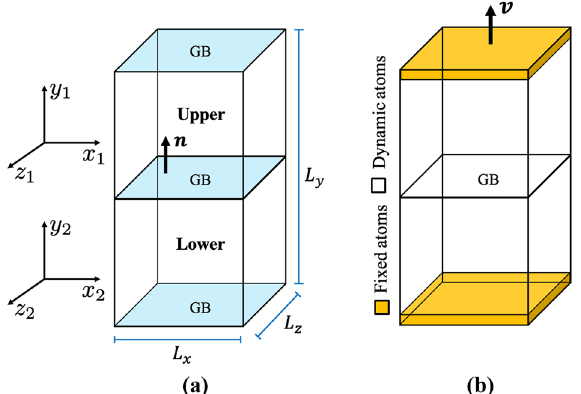
Figure 2. A schematic depicting (a) the geometry of the atomistic bicrystal system and (b) the configuration used in the mechanical loading simulations.